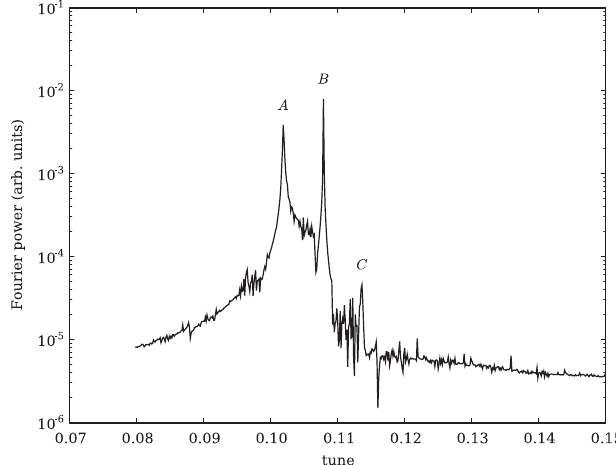
FIG. 1. Simulated mode spectra in the VEPP-2M collider with (cid:9) ¼ 0 : 008 showing synchrobetatron modes. The line indicated by A is the base tune, B is the first synchrobetatron mode, and C is the beam-beam (cid:1) mode.